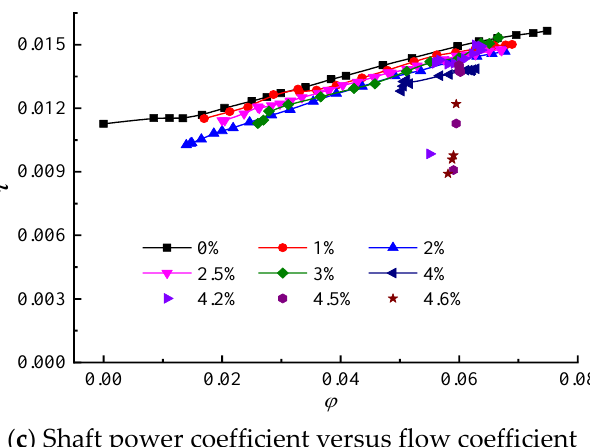
Figure 3. Pump performance curves. (values in % correspond to different inlet void fraction α ) (( a , b ) are adapted from ref. [11]) .